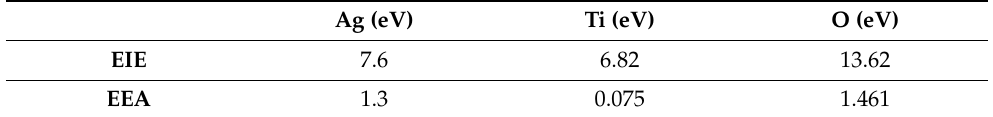
Table 3. Ionization energy and Electron affinity of the elements